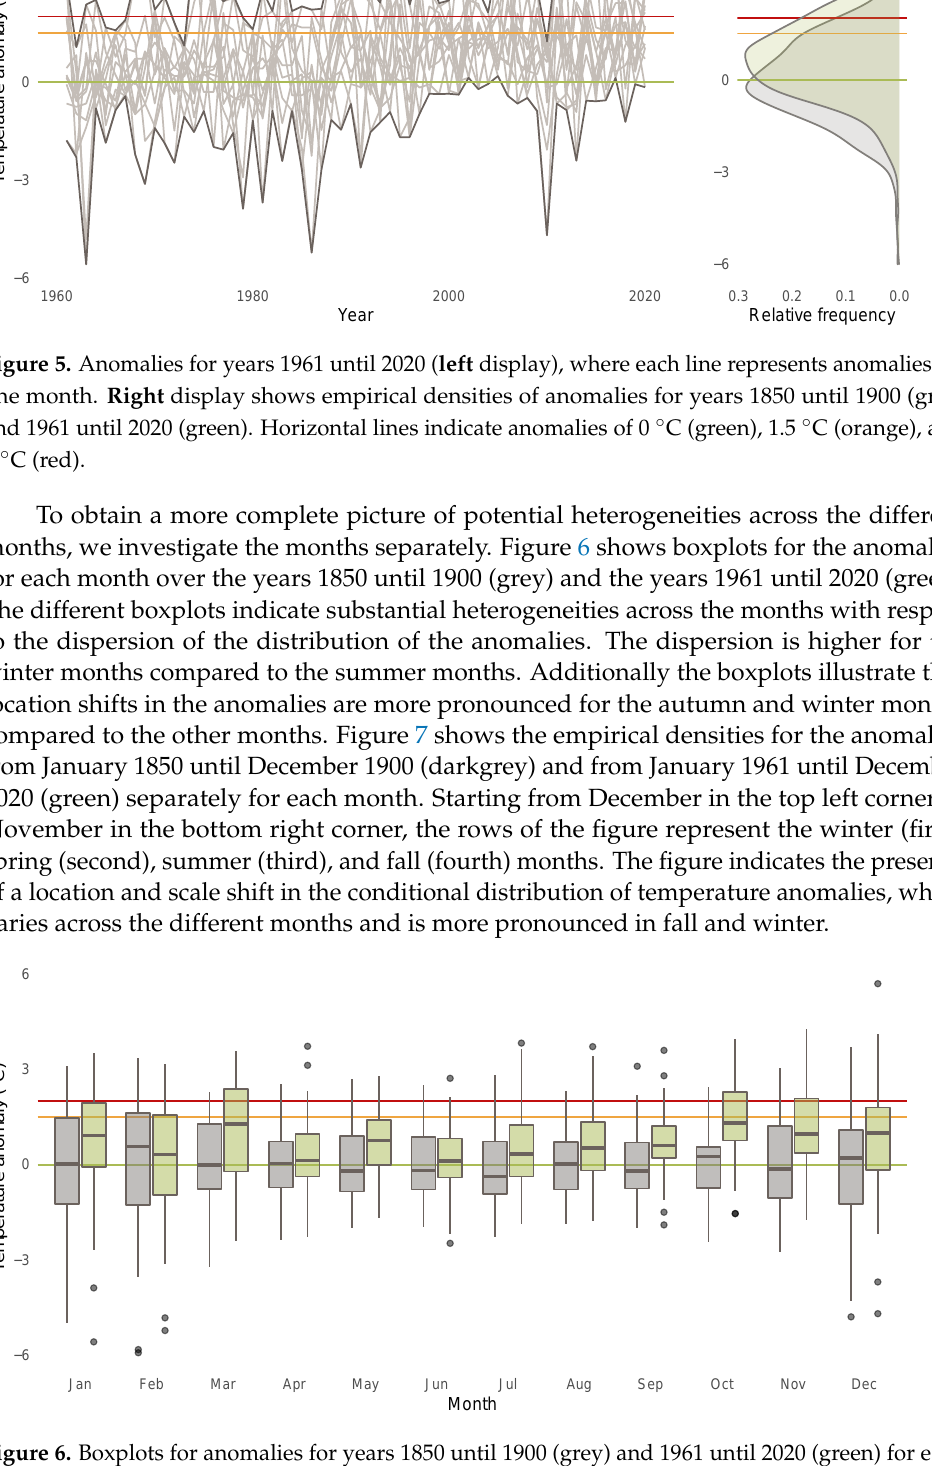
Figure 6. Boxplots for anomalies for years 1850 until 1900 (grey) and 1961 until 2020 (green) for each month. Horizontal lines indicate anomalies of 0 ◦ C (green), 1.5 ◦ C (orange), and 2 ◦ C